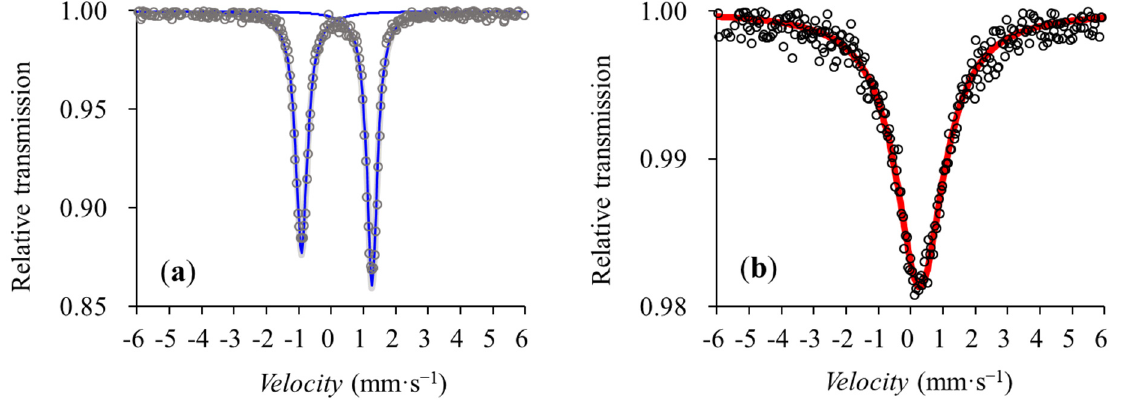
Figure 3. Mössbauer spectra of 1-Cl at ( a ) 123 K and ( b ) 300 K. Open circles and lines are measurement data and fitting curves, respectively.